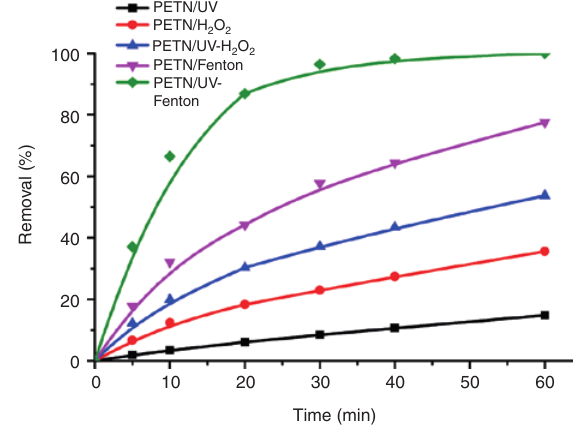
Figure 2: Efficiency of PETN removal vs. time in different advanced oxidation